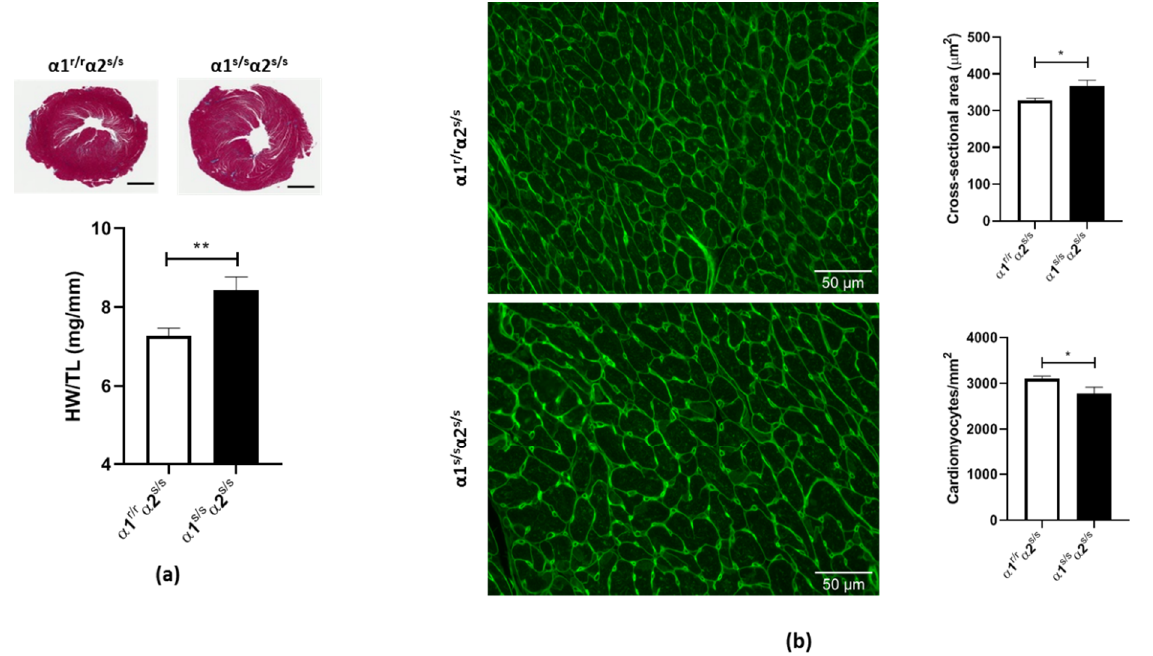
Figure 2. Cardiac hypertrophy in α 1 s/s α 2 s/s mice: ( a ) Cross-section of whole left ventricles stained with Masson’s trichrome (top); scale bar = 1 mm. Heart weight/tibia length (HW/TL) quantification (bottom) ( n = 14–16 hearts/genotype). ( b ) Wheat germ agglutinin (WGA) staining of left ventricle cross-sections from α 1 r/r α 2 s/s (top left) and α 1 s/s α 2 s/s (bottom left) mice; scale bar = 50 μ m. Average cardiomyocyte cross-sectional area (top right) was automatically quantified in over 1000 cells from at least five different random fields ( n = 4 – 7 hearts/genotype). Cardiomyocyte density (bottom right) was determined by the number of cardiomyocytes per mm 2 . * p < 0.05; ** p < 0.01.